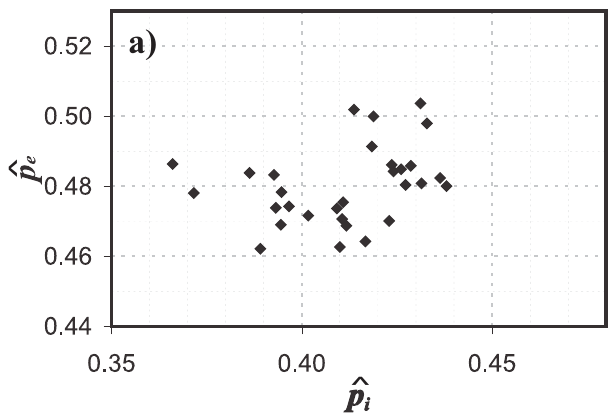
Fig. 2. (a) Parameter space determined by the estimated parameters p i and p e for generators sampled from different regions in the